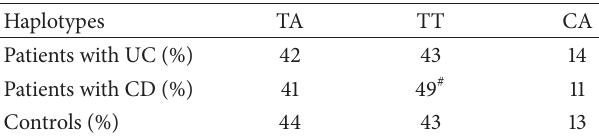
Table 3: Haplotypes of FUT2 gene in patients with IBD and the